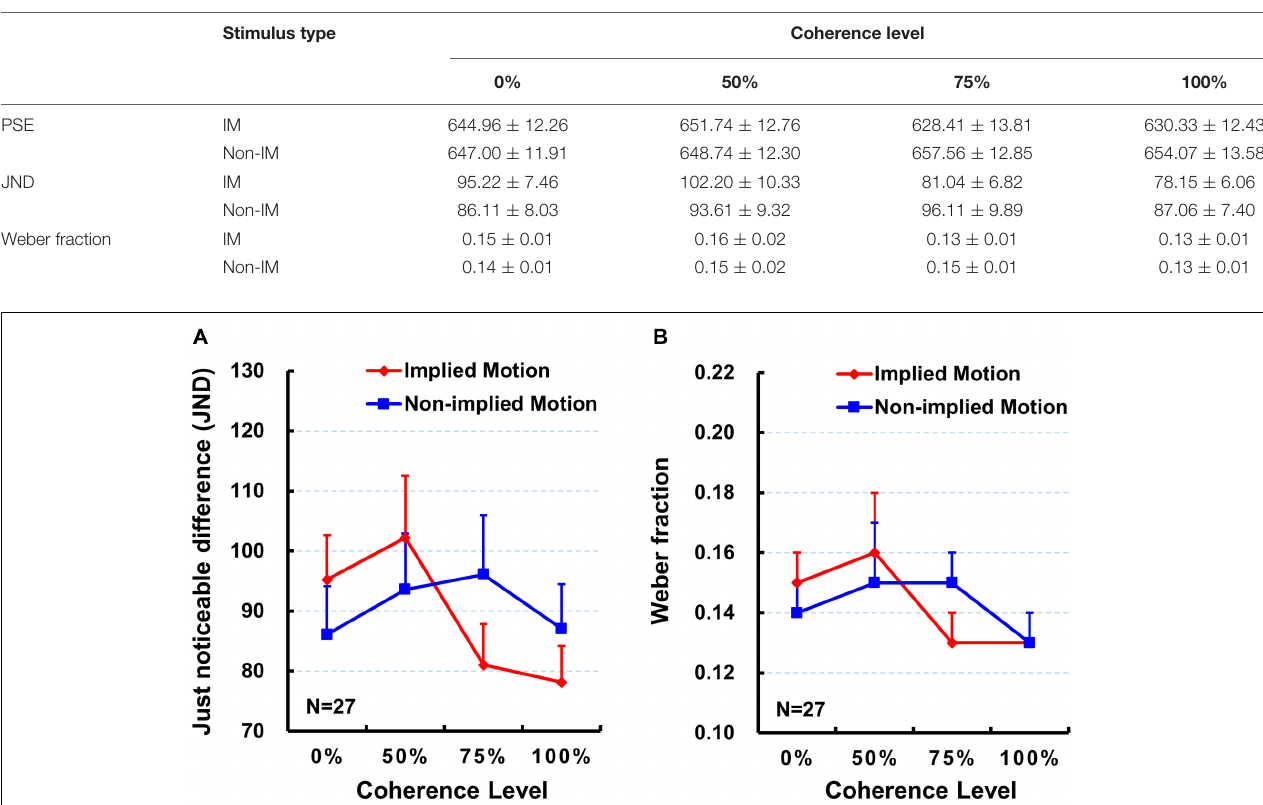
TABLE 1 | The descriptive statistics results of PSE, JND, and Weber fraction (mean ± SE).